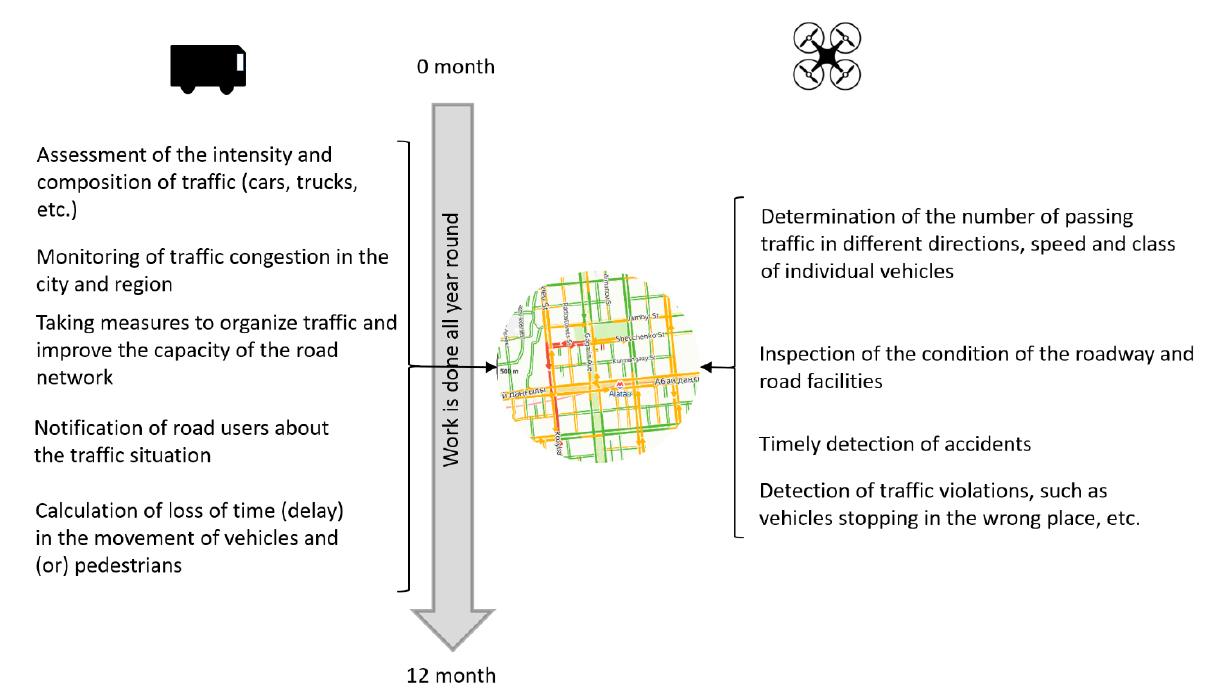
Figure 9. Traffic monitoring. Source: Generated by the authors.